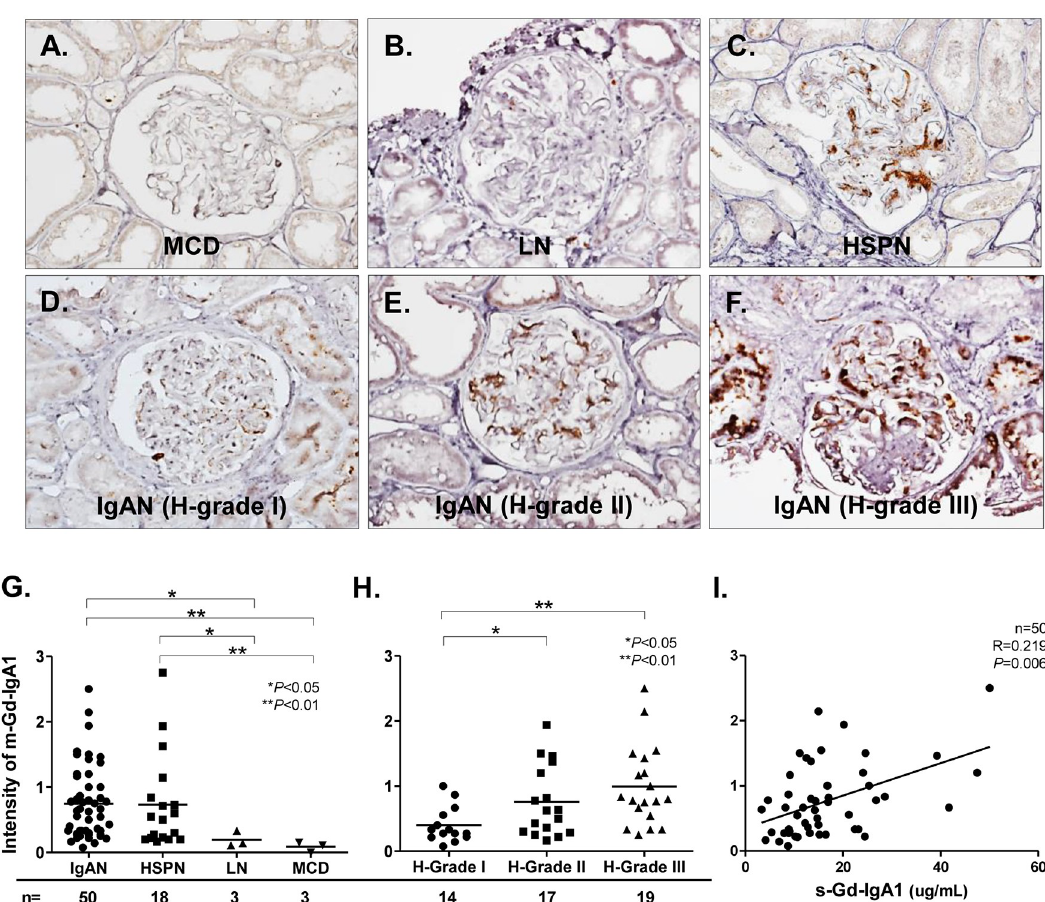
Fig 2. Glomerular m-Gd-IgA1 deposition identified by IHC staining for KM55. Representative photos of glomerular m-Gd-IgA1 (brown reaction product) in patients with MCD (A) , LN (B) , HSPN (C) , and IgAN (D-F) . Original magnification: × 40. Intensity of glomerular m-Gd-IgA1 compared between IgAN and other kidney diseases (G) . Intensity of m-Gd-IgA1 in IgAN according to JSN histological grade (H) . Correlation between m-Gd-IgA1 positivity and s-Gd-IgA1 level in patients with IgAN (I) . Horizontal solid lines represent means. Data were statistically analyzed using Kruskal-Wallis tests, Mann-Whitney U tests, and Spearman correlations. Considering renal function, s-Gd-IgA1 tended to correlate with sCr values (r = 0.038, p = 0.081) (Fig 3D) and global sclerosis rates (r = 0.063, p = 0.046) (Fig 3G). Furthermore, m- Gd-IgA1 correlated significantly and negatively with eGFR (r = 0.131, p = 0.001) (Fig 4E) and positively with global sclerosis plus crescent rates (r = 0.101, p = 0.024) (Fig 4I). However, nei- ther type of Gd-IgA1 correlated with proteinuria or crescent rates. Based on the Oxford classi- fication, s-Gd-IgA1 values were significantly higher in patients with segmental sclerosis and tubular atrophy/interstitial fibrosis (S0 vs. S1: 15.5 ± 7.8 vs. 20.1 ± 13.6 μ g/mL, p = 0.023) (T0 vs. T1-2: 15.4 ± 8.1 vs. 20.4 ± 12.4 μ g/mL, p = 0.017) (Fig 3L and 3M), and m-Gd-IgA1 inten- sity was similar (S0 vs. S1: 0.6 ± 0.4 vs. 1.3 ± 0.6, p < 0.001) (T0 vs. T1-2: 0.7 ± 0.4 vs. 0.9 ± 0.8,